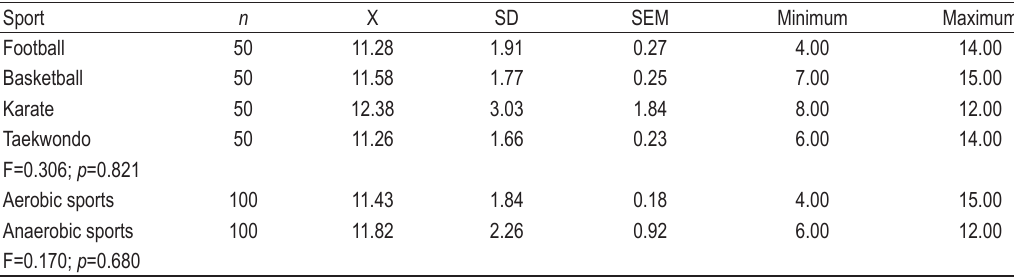
TABLE 4. The average age of patients at which knee pain or swelling first